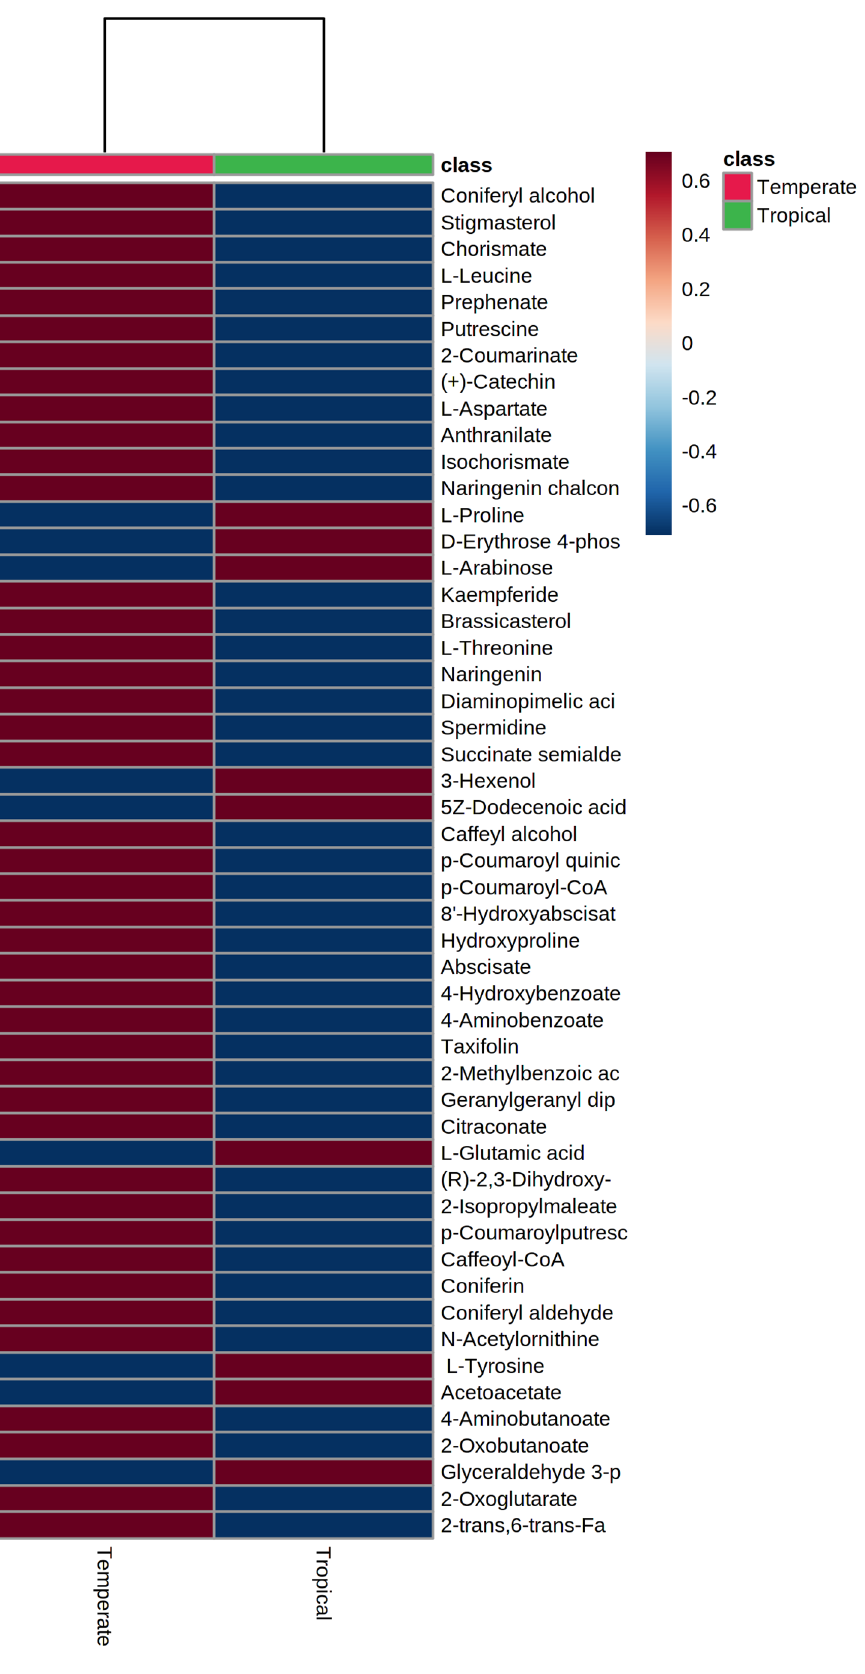
Figure 5. Heatmap of PLS-DA VIP metabolites differentiating temperate and tropical sorghum.